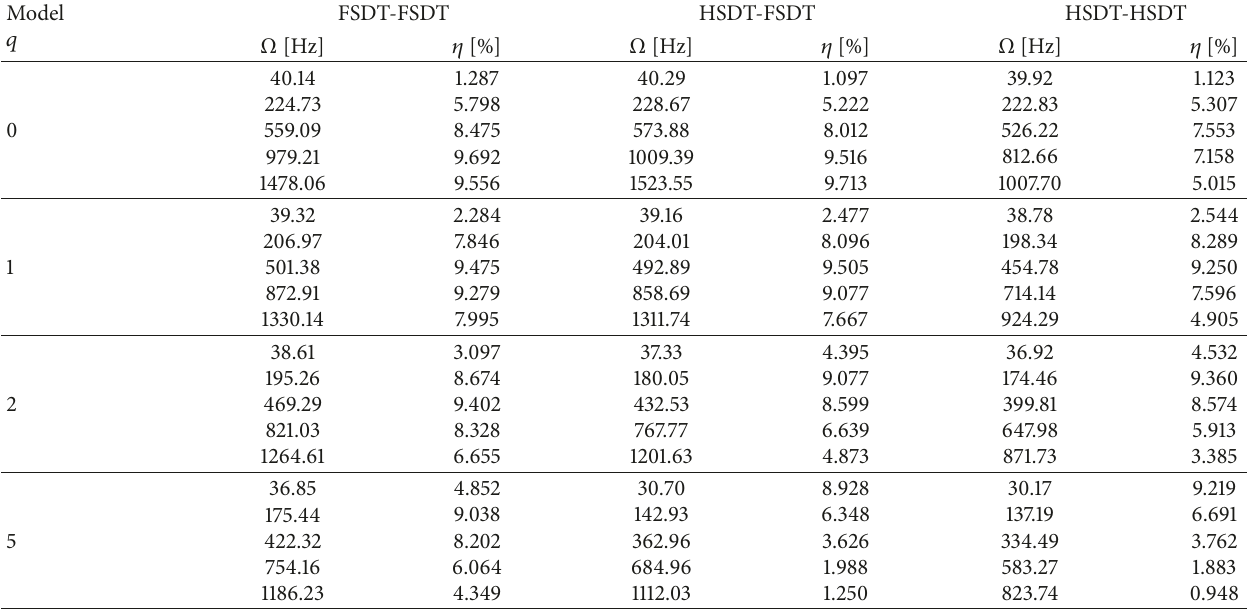
Table 15: Frequencies Ω and loss factors 𝜂 . 𝑤 GNP = 5 % . Core ( 𝐶1 – 𝐶3 ). Mg, 𝑝 = 0 .